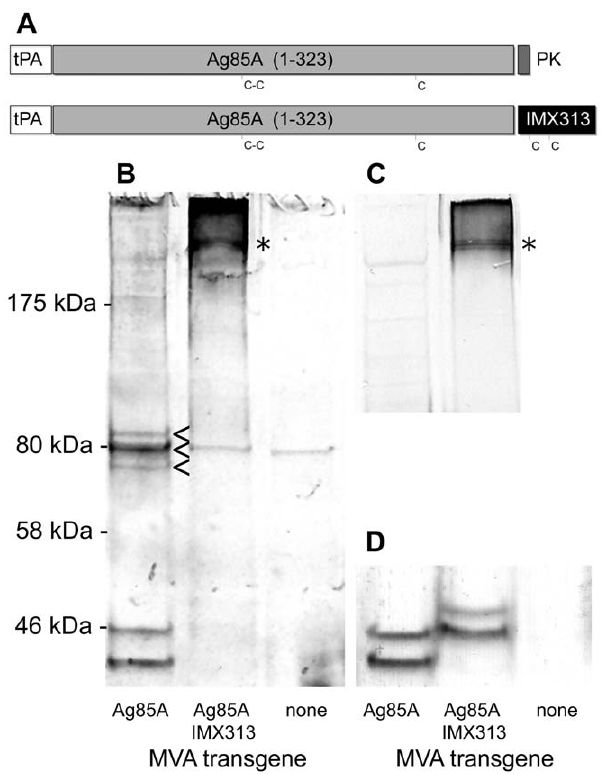
Figure 1. Schematic representation of Ag85A and Ag85A IMX313 protein constructs. ( A ). tPA=signal peptide from human tissue plasminogen activator (30 aa); Ag85A(1–323)=residues 1 to 323 of M. tuberculosis antigen 85A; PK=SV5-PK epitope tag (9 aa); IMX313=hybrid chicken oligomerization domain of C4bp (55 aa). C indicates cysteine residue. Western blots labeled with anti-Ag85A polyclonal antibody ( B and D ) or anti-IMX313 polyclonal antibody ( C ) of non-reducing ( B and C ) and reducing ( D ) SDS-PAGE gels of BHK cell lysates 24 h post infection with the indicated viruses. Arrowheads indicate disulphide-linked dimers formed by Ag85A and asterisks indicate higher molecular weight disulphide-linked multimers, presum- ably heptamers, formed by Ag85A